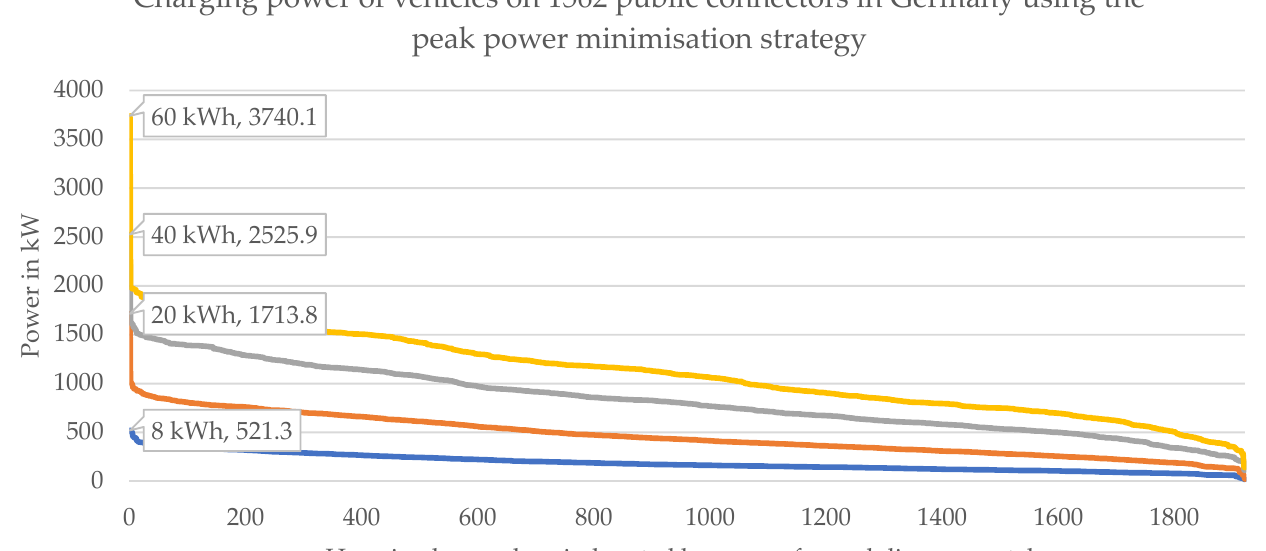
Hour in observed period sorted by power for each line seperately